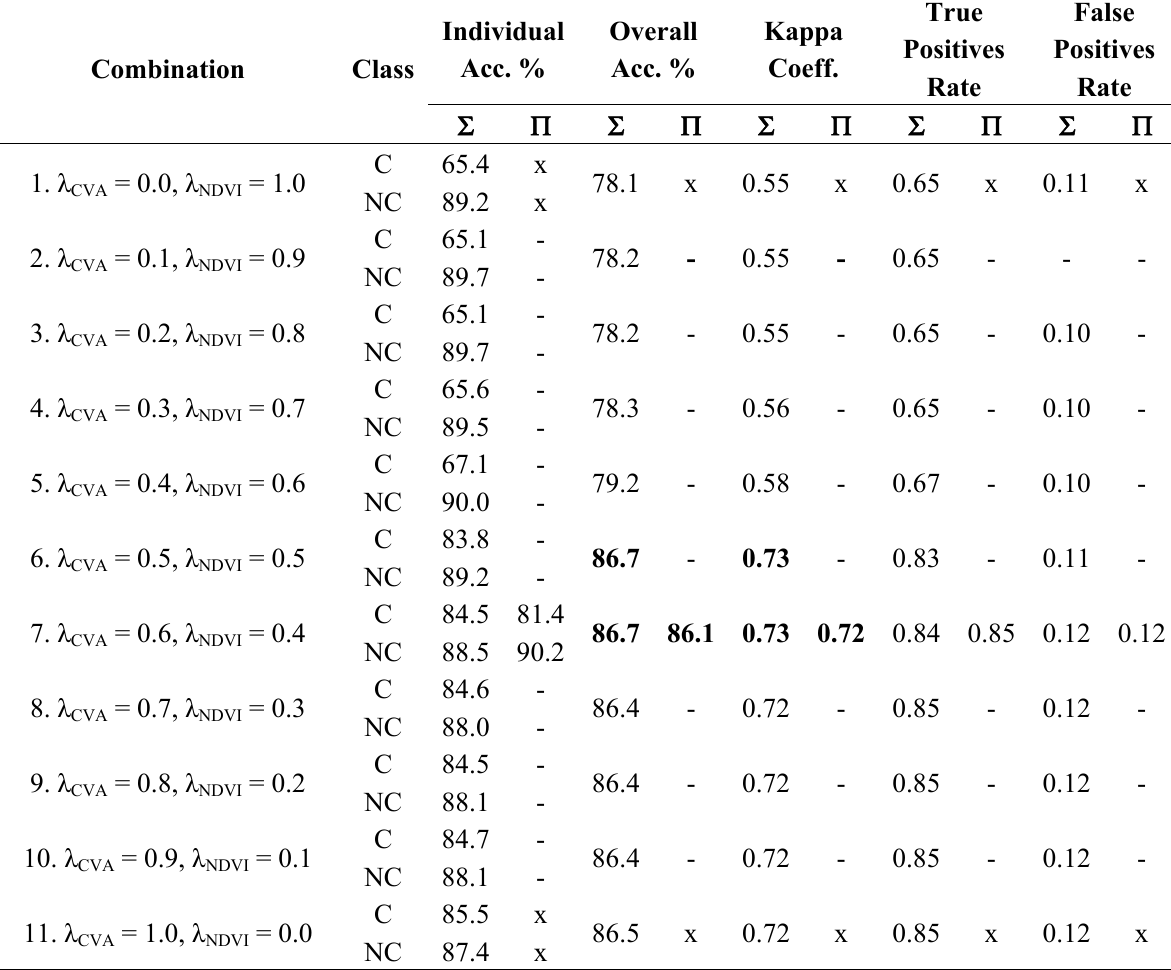
Table 4. Level 1. Individual and global accuracies obtained for the multisource process as a function of the weights assigned to each index (CVA & Diff. NDVI). Sumative method ( Σ ), Multiplicative method ( Π